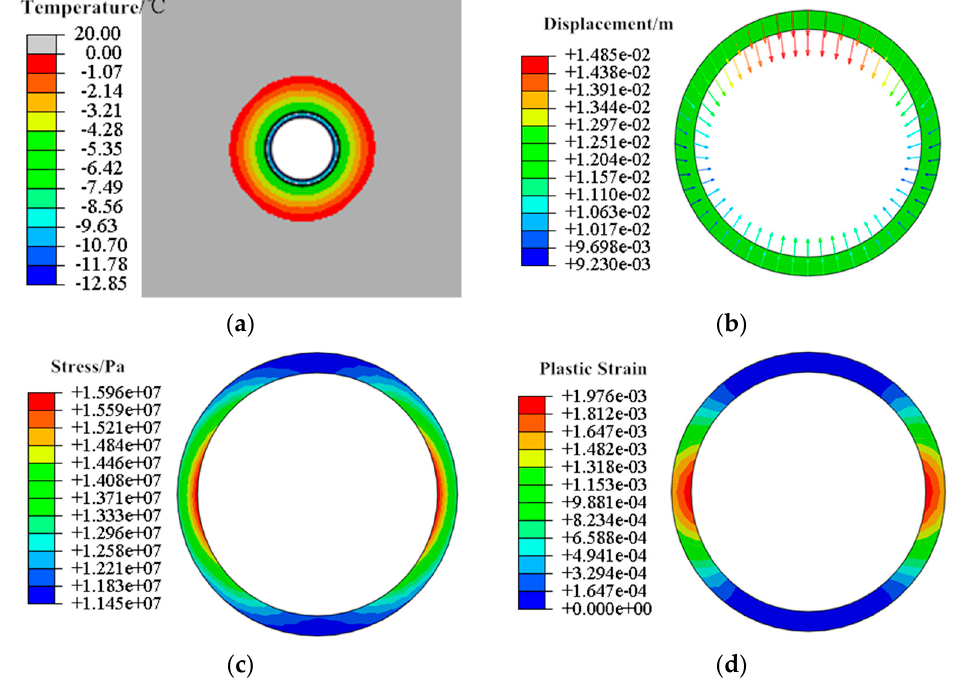
Figure 4. Numerical calculation results.